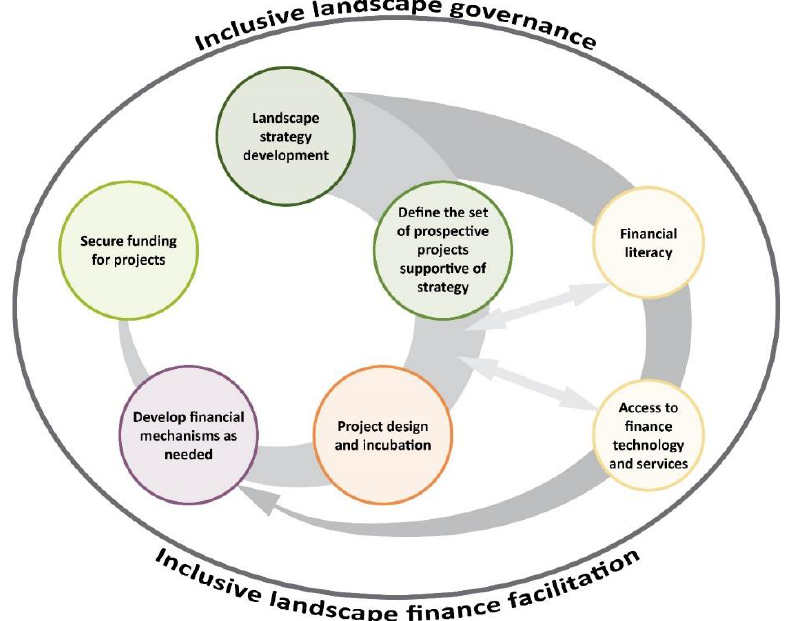
Figure 4. Proposed framework for inclusive integrated landscape finance (adjusted from Figure 1).